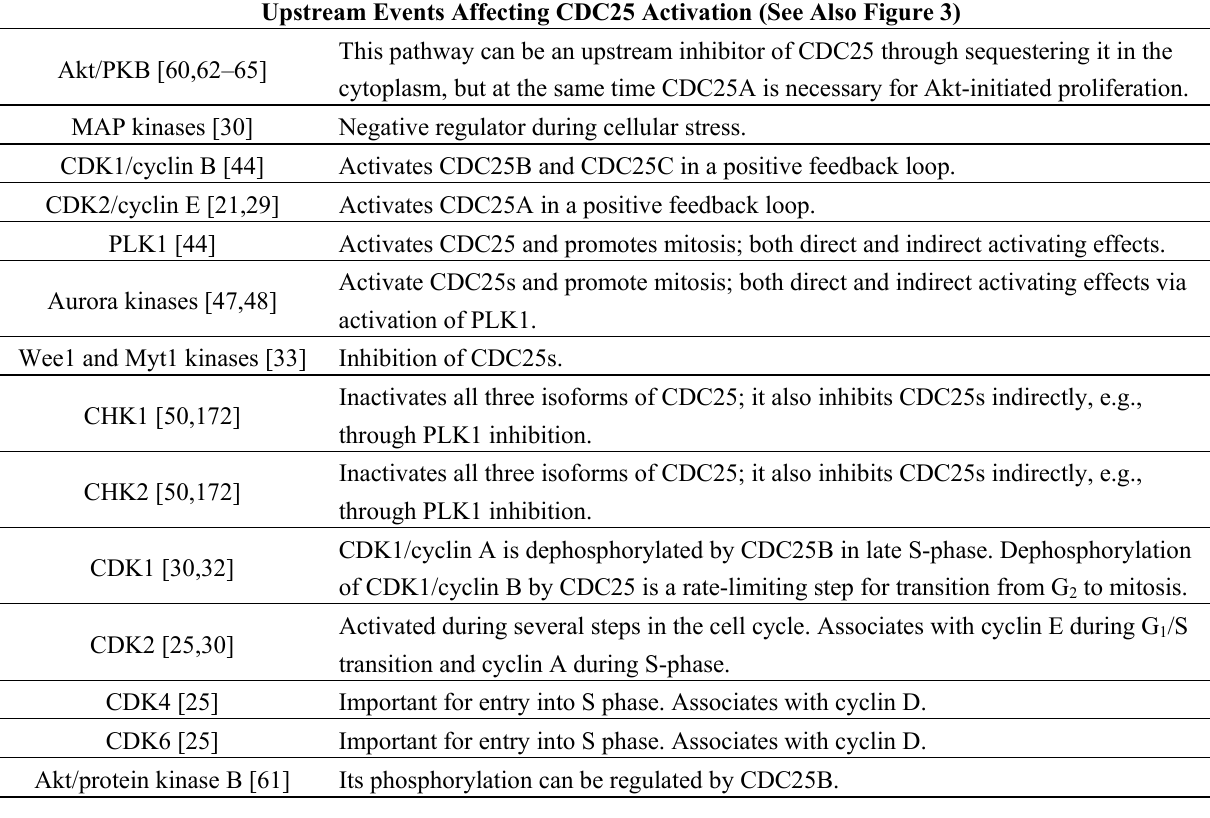
Table 5. CDC25 and the most important members of its interacting kinase network—an